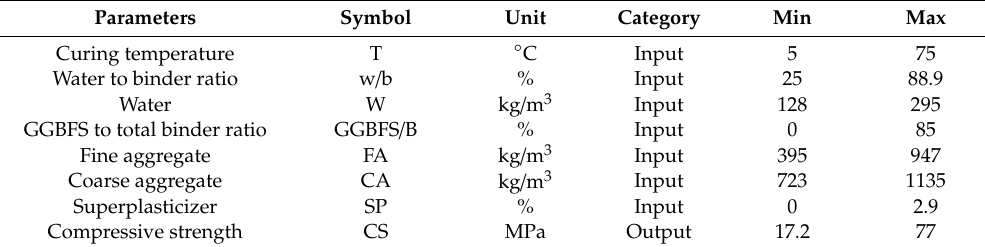
Table 1. Ranges of the input and output parameters in the